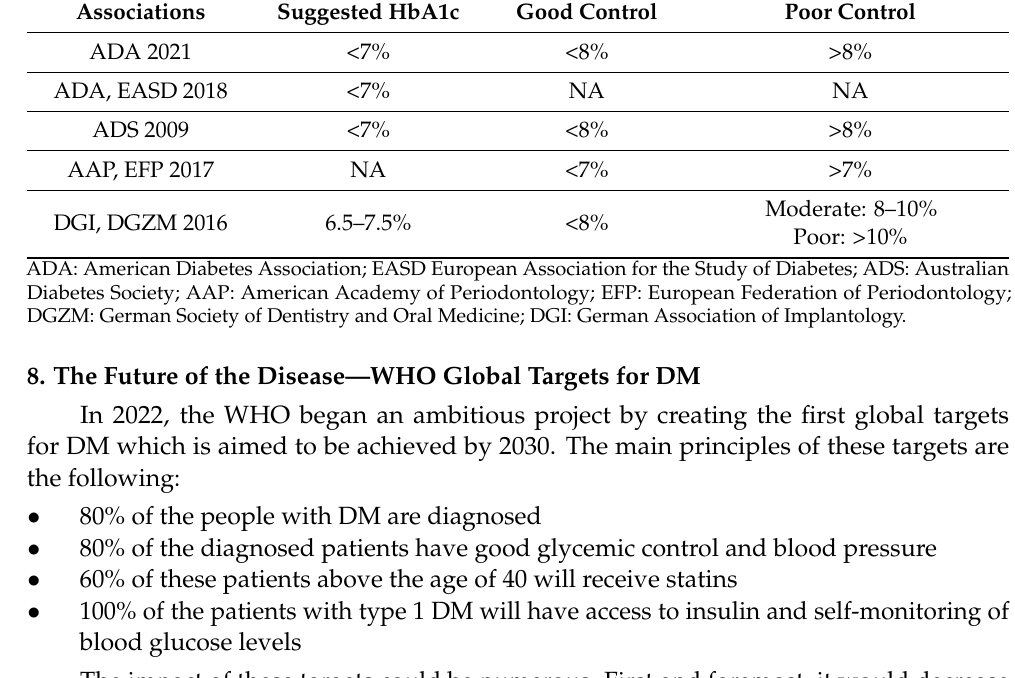
Table 3. Important glycemic targets according to the major associations. Associations Suggested